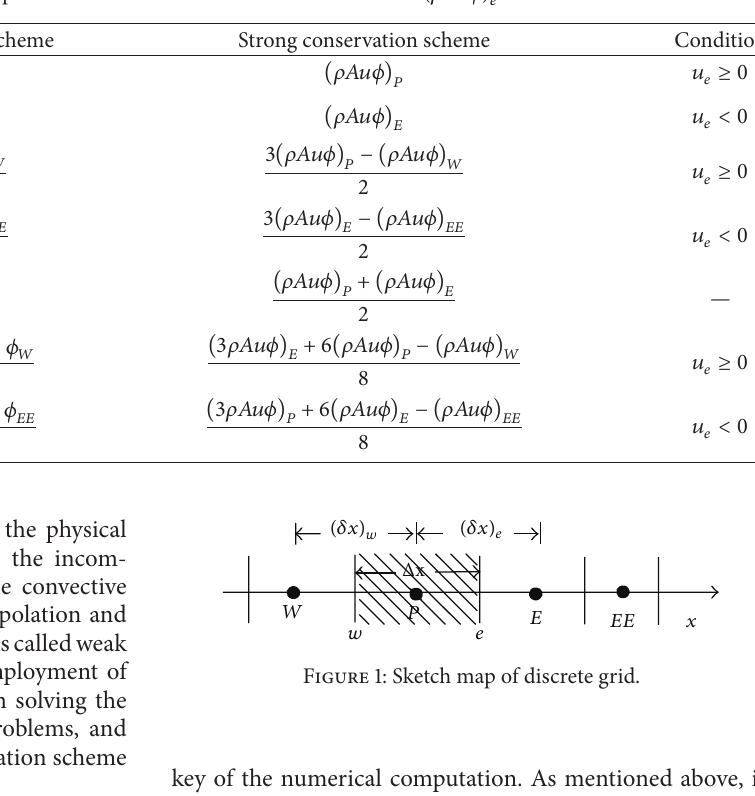
Table 1: Discretized expressions of the convective flux at the interface (𝜌𝐴𝑢𝜙) 𝑒 .